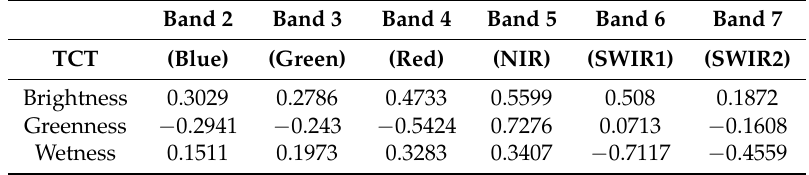
Table 3. TCT coefficients for Landsat 8 reflectance data.